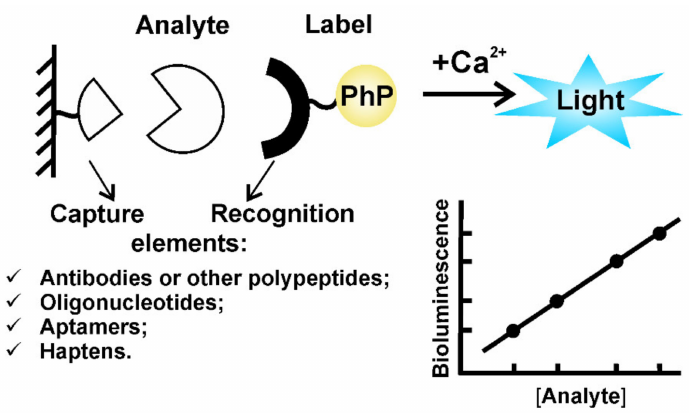
Figure 4. General scheme for bioluminescent solid-phase binding assay. Label is a chemically synthesized conjugate or genetically fused recognition element with a reporter molecule